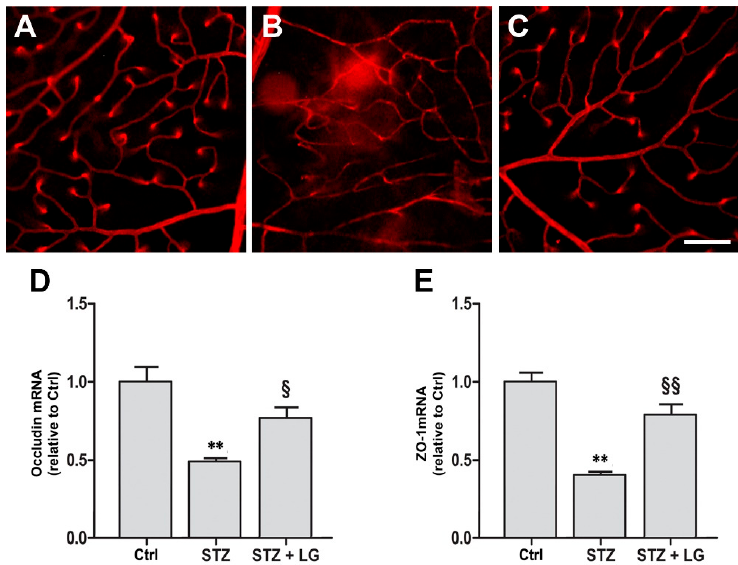
Figure 9. Effects of LG on blood-retinal barrier (BRB) integrity. Blood-retinal vascular leakage was evaluated with the Evans blue method in control rats ( A ), in STZ rats ( B ), and in STZ rats treated with LG ( C ). Scale bar: 100 μ m. ( D , E ) Occludin and zonula occludens-1 (ZO-1), respectively, mRNA expression evaluated with qPCR in control retinas and in retinas of STZ rats with or without LG treatment. Each column represents mean ± SD. ** p < 0.01 vs. Ctrl; § p < 0.05 vs. STZ; §§ p < 0.01 vs. STZ; n = 3 for all measures. Power value: 0.83 ( D ), 0.99 ( E